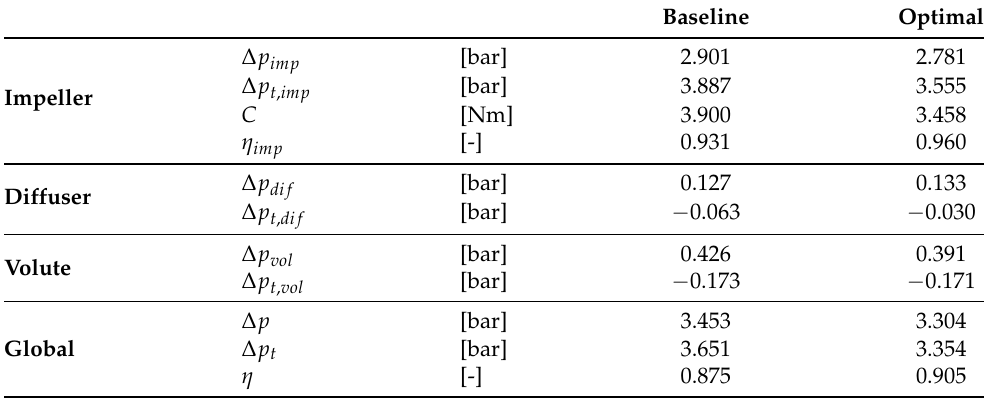
Table 6. Comparison of the baseline and the optimal design for the impeller, the vaneless diffuser and the volute. η imp is the impeller efficiency, C the torque absorbed by the pump shaft, ∆ p the static pressure variation, ∆ p tot the total pressure variation, η the pump hydraulic